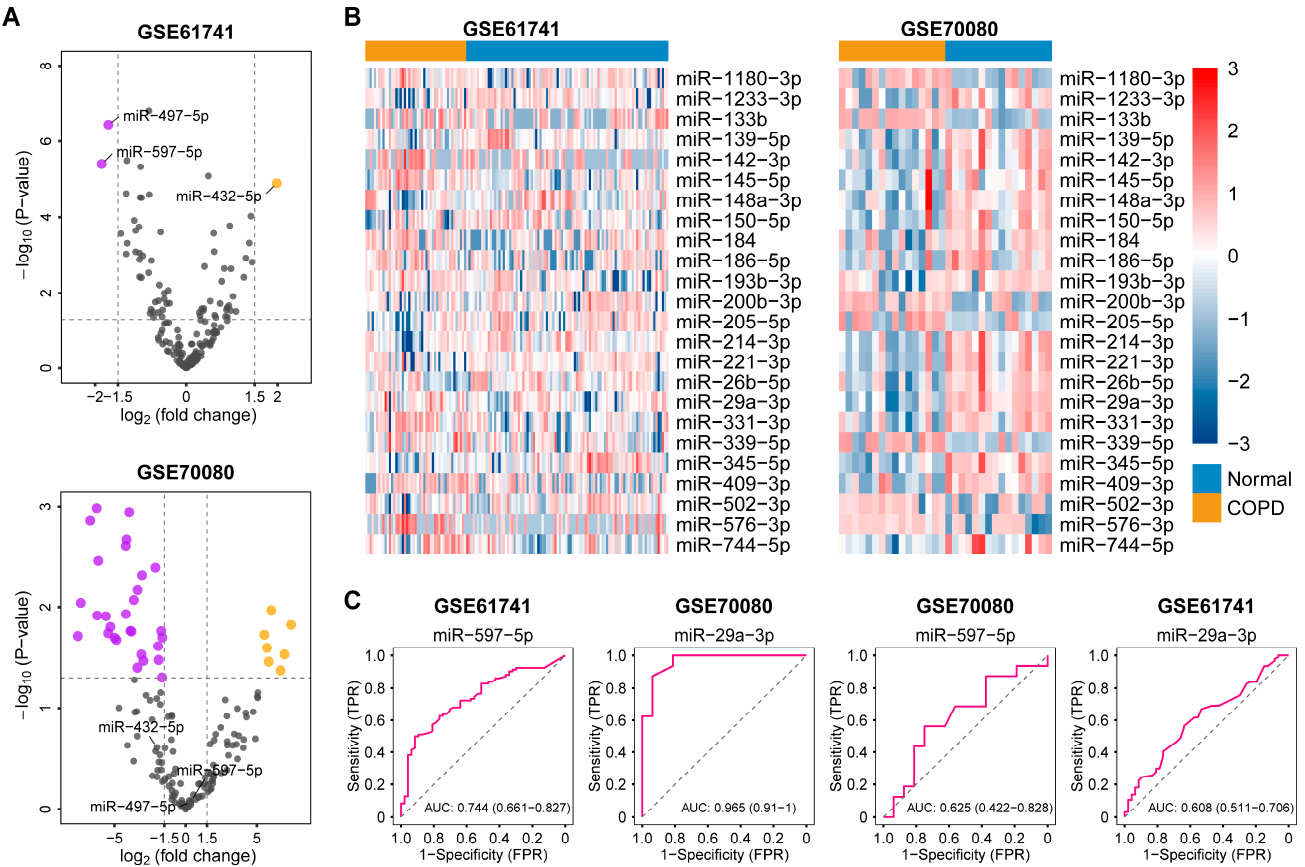
Figure 2. Comparison of the miRNA expression patterns and evaluation of the diagnostic value of miRNAs in two discovery datasets. ( A ) Volcano plots of DEmiRs (|log2FC| > 1.5 and p -value < 0.05) in samples from COPD and healthy controls in the GSE61741 and GSE70080 datasets. The yellow dots represent significantly up-regulated miRNAs in COPD, while the purple dots correspond to down-regulated miRNAs; ( B ) Heatmaps of the expression patterns of DEmiRs with a less stringent range ( p -value < 0.05) between COPD and healthy controls in the two cohorts. Normalized expression values were scaled to the range of − 3 to 3; ( C ) Receiver operating characteristic (ROC) curves measuring the performance of two representative miRNAs for predicting COPD and normal controls in the two